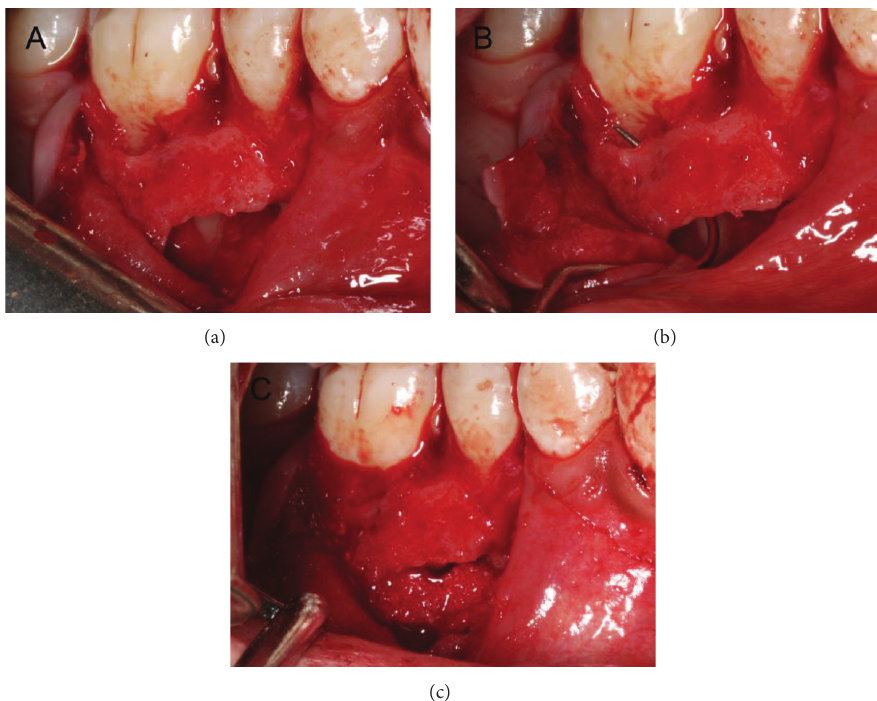
Figure 3: Intraoperative photographs. (a) Osseous destruction region did not involve the root apex of tooth 30. (b) Osseous destruction region around the root apex of tooth 29 penetrated through periodontal ligament of the mesial root and involved the furcation area of tooth 30. (c) Osseous destruction region was filled with Bio-Oss